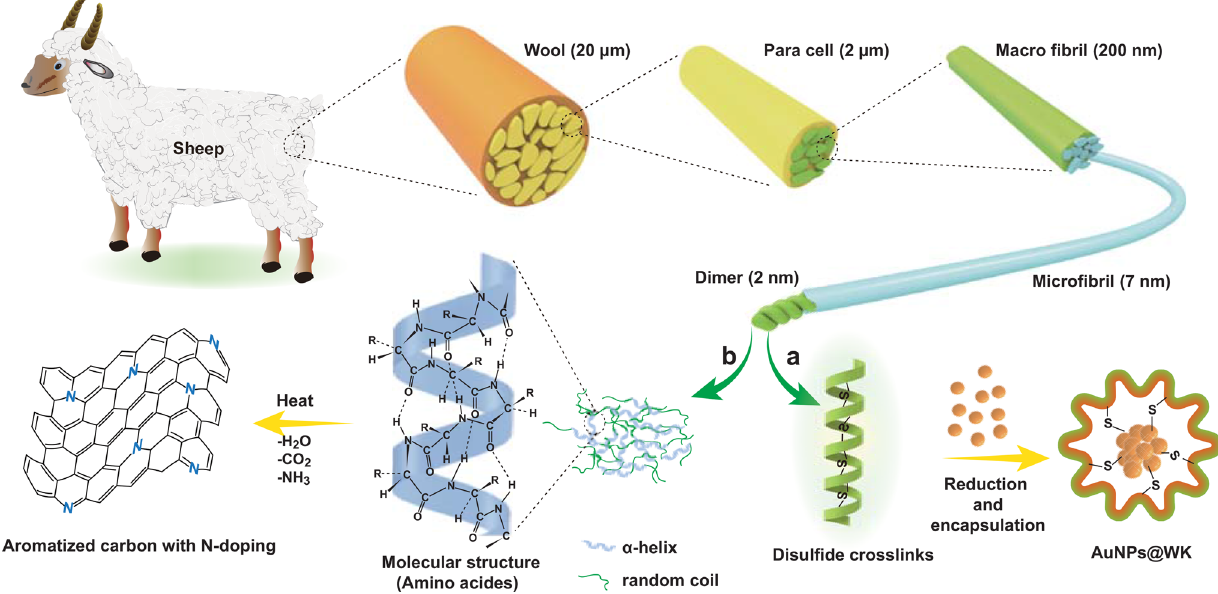
Fig. 1 Schematic representation for the fabrication of a wool keratin-encapsulated gold nanoparticles and b nitrogen-doped aromatized